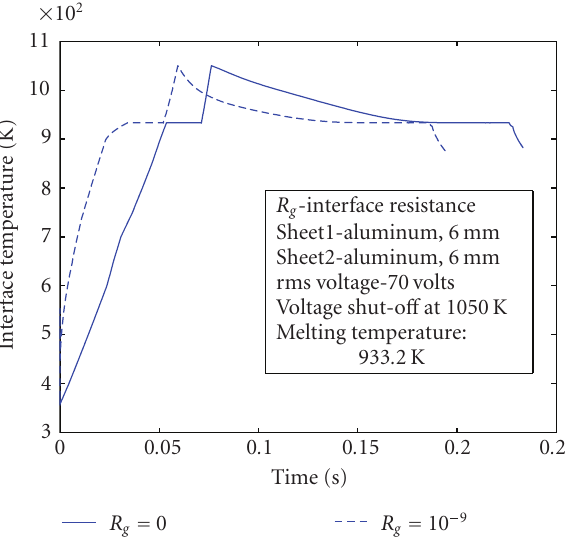
Figure 4.2. Example 1: temporal variation of interface temperature for two values of R g